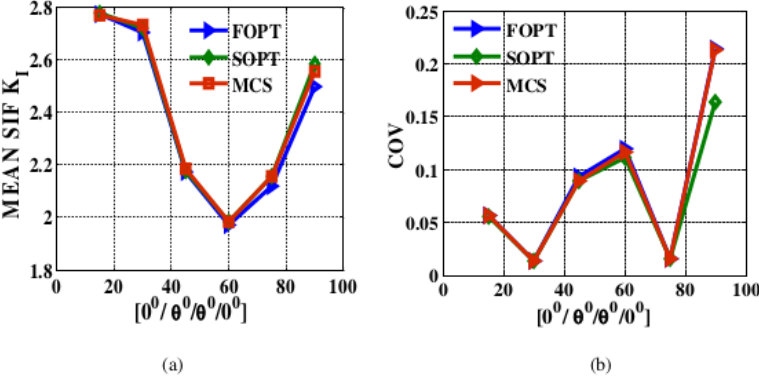
Figure 2: Effect of different lamination angles with random change in crack length ( cl ) on (a) mean of SIF K I and (b) COV of SIF K I .